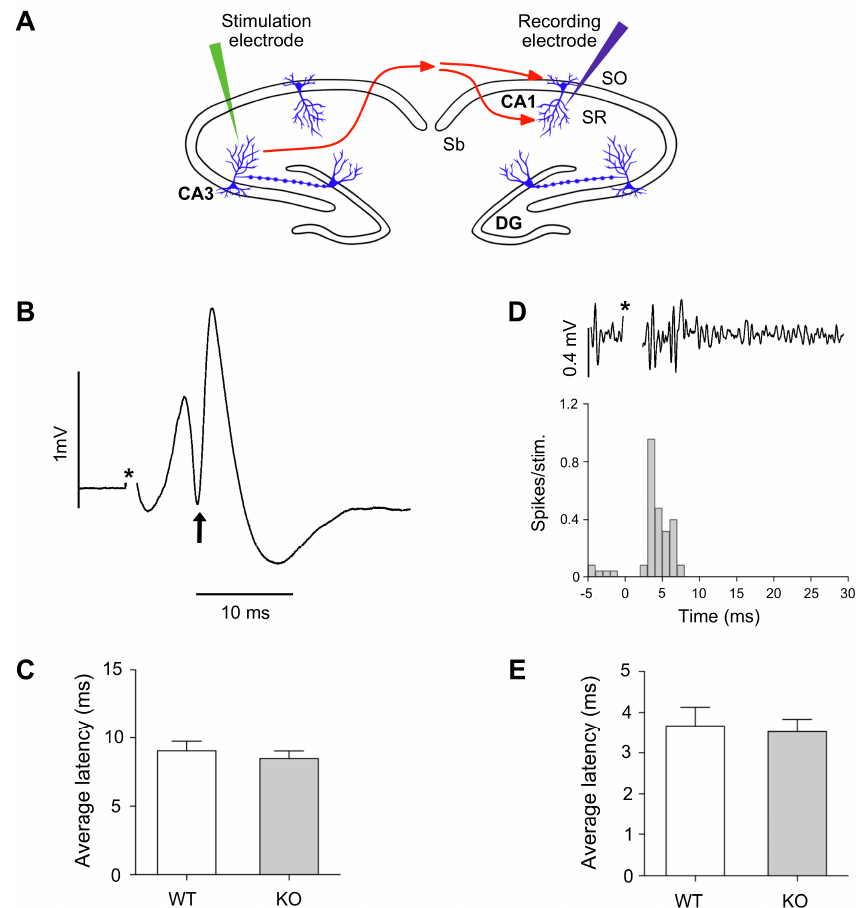
Figure 5. ( A ) Schematic representation of the in vivo electrophysiological setup. Stimulation electrodes were stereotactically located at CA3 hippocampal level of WT or Lgals4-KO mice, and recording electrodes were located at the CA1 region of the contralateral hemispheres. Latencies between stimuli and evocated neuronal responses were used to estimate the speed of impulse transmission along myelinated axon projections of the hippocampal commissure between these two regions. ( B ) Example of a local field potential recording of a populational spike in CA1 in response to CA3 stimulation (averaged from 32 stimuli). Latency was considered as the time between stimulation (*) and the negative peak of the populational spike (arrow). ( C ) Populational data from control group and Lgals4- KO group showing average latency values from peaks of populational spikes (error bars are SEM). ( D ) Example of multiunit activity showing action potentials in CA1 in response to stimulation in CA3 (upper trace). Peri-stimulus time histogram (PSTH) obtained from multiunit activity in CA1 in response to stimulation of CA3 (32 stim). Latency was considered as the first bin showing increased values above baseline (3 ms in the example). ( E ) Populational data from control group and Lgals4-KO group showing average latency values from first bin of response in PSTH (error bars are SEM). Note that in both recordings electrical artifact of the stimulation has been removed and marked by an asterisk